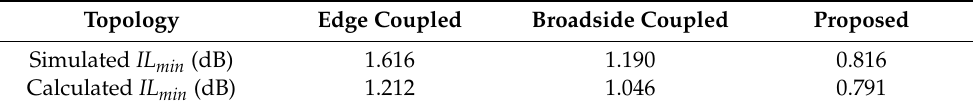
Table 1. Simulated and calculated IL min *.